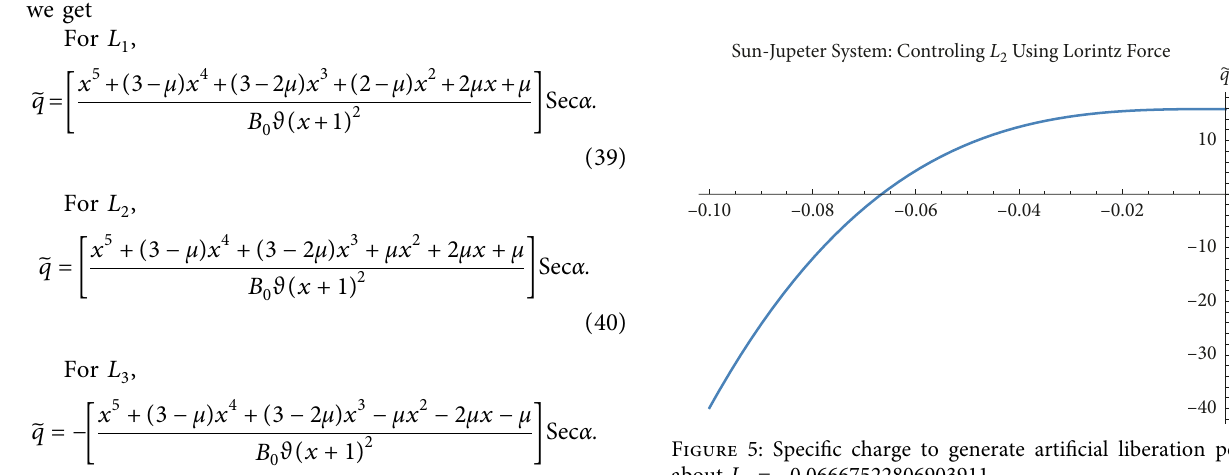
Figure 4: Specific charge to generate artificial liberation points � − 1 . 9994437087809749. about L 1